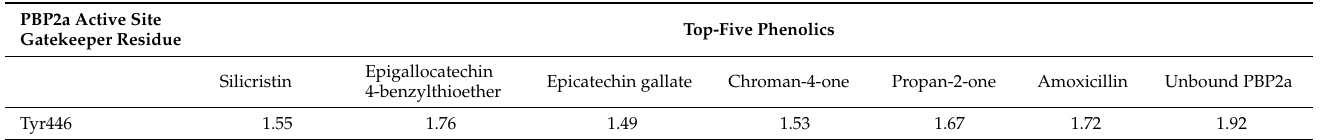
Figure 9. Comparative root-mean-square fluctuation (RMSF) plots of alpha-carbon, the top-five phenolics, and amoxicillin against residues of PBP2a of S. aureus ( a ), and gatekeeper residue [Tyr446 (black arrow)] of PBP2a ( b ) when the top-five phenolics and amoxicillin were bound at the active site of PBP2a over a 120 ns MD simulation period. Table 4. PBP2a active site gatekeeper residue average fluctuation (Å) after 120 ns simulation of the top-five phenolics at the active